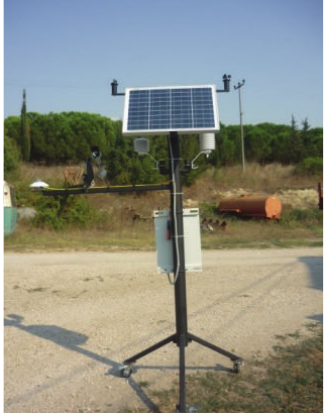
Figure 3: Climatic